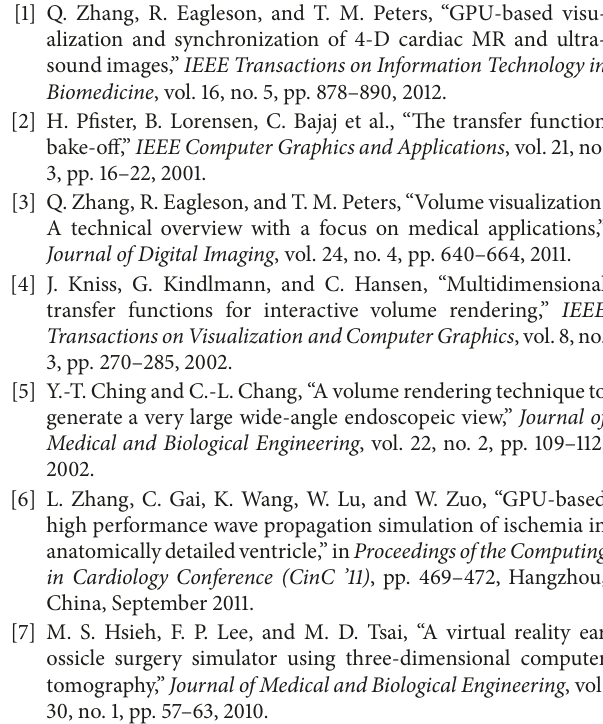
objects are effectively emphasized. The features of interest in the data can thus be found exactly by mapping scalar value of boundary voxels which correspond to the points in LH histogram to appropriate opacity and